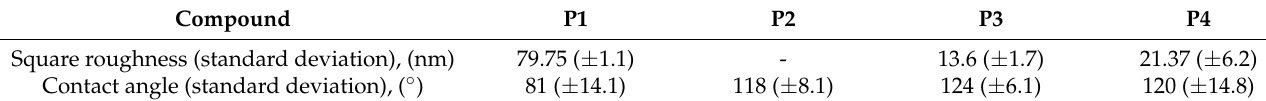
Table 1. The square roughness and contact angle measured for the coated fabrics.